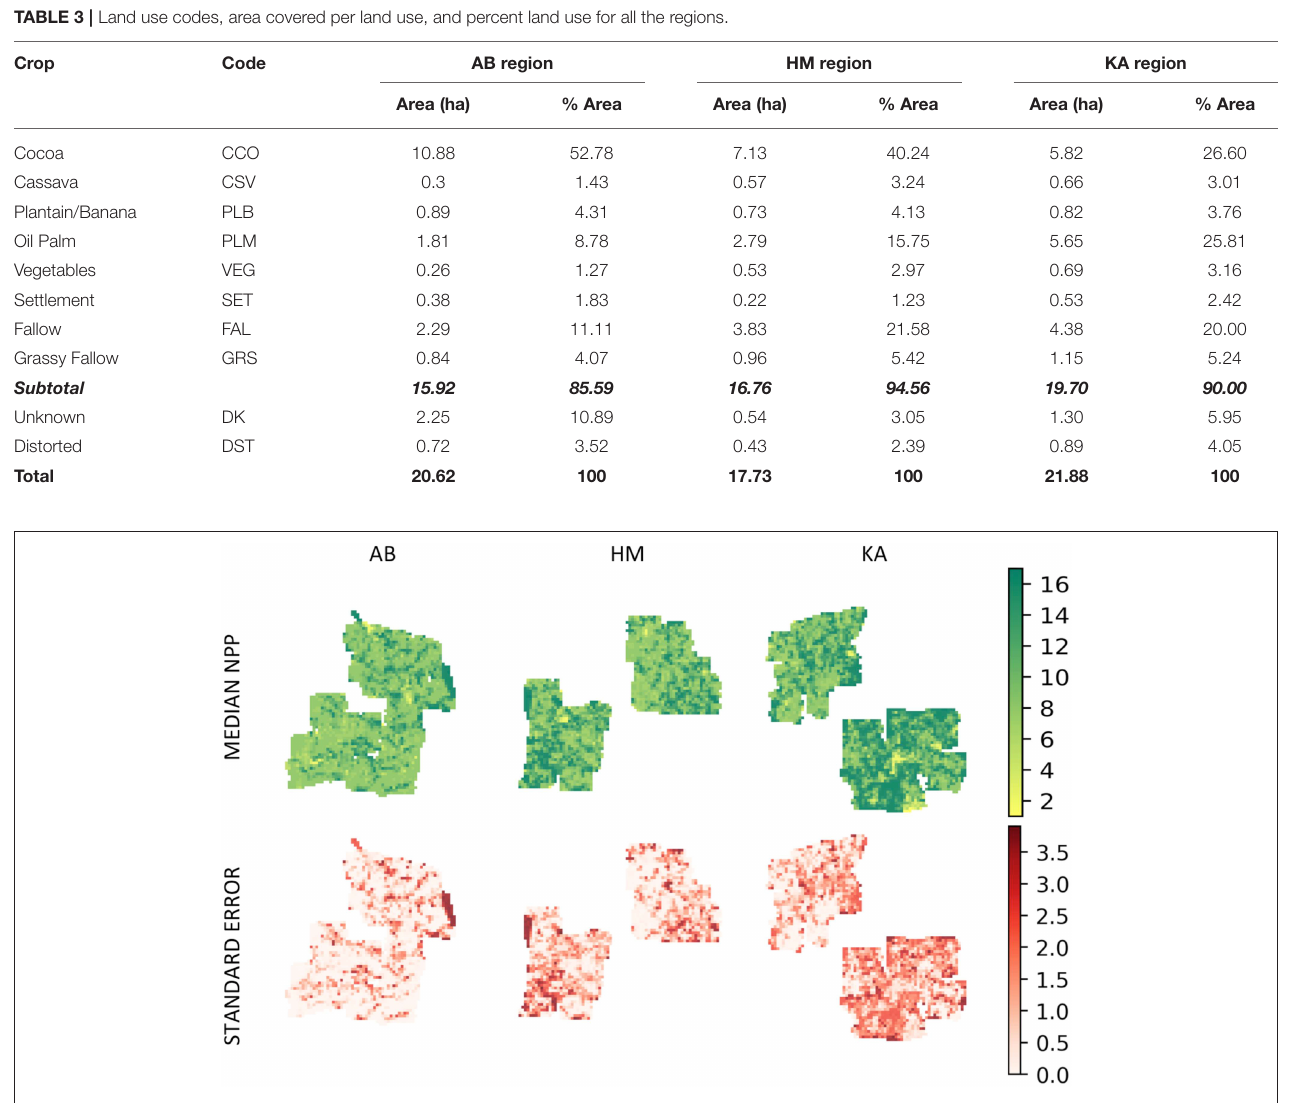
FIGURE 6 | NPP and standard deviation values per hectare of the AB, HM, and KA regions assuming a density of 600 trees per